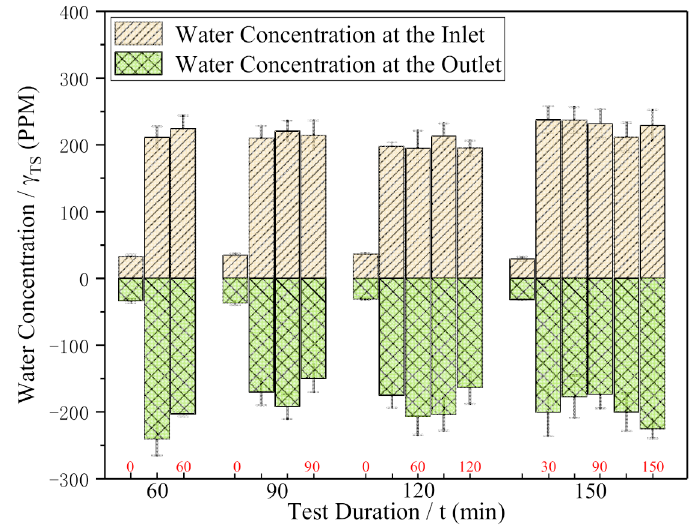
Figure 6. Water concentration of the fuel sample at the inlet and outlet of the test loop.